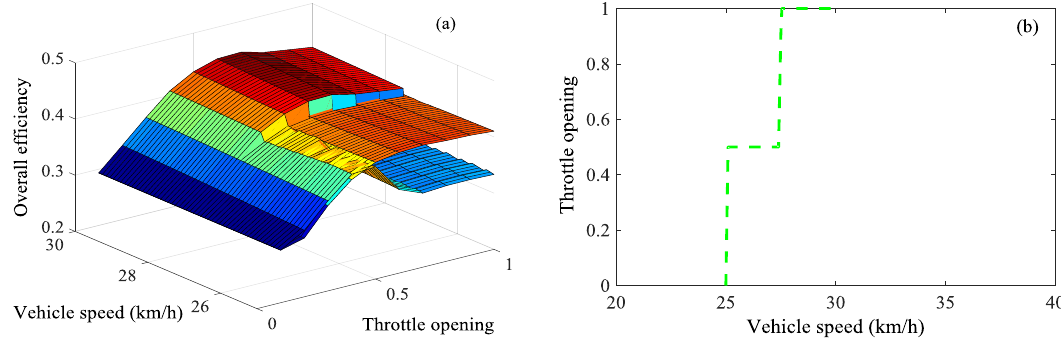
Figure 12. Intersection line of curved surfaces between EVT Mode 1 and EVT Mode 2: ( a ) intersection line based on three-dimensional view; and ( b ) intersection line based on two-dimensional view.